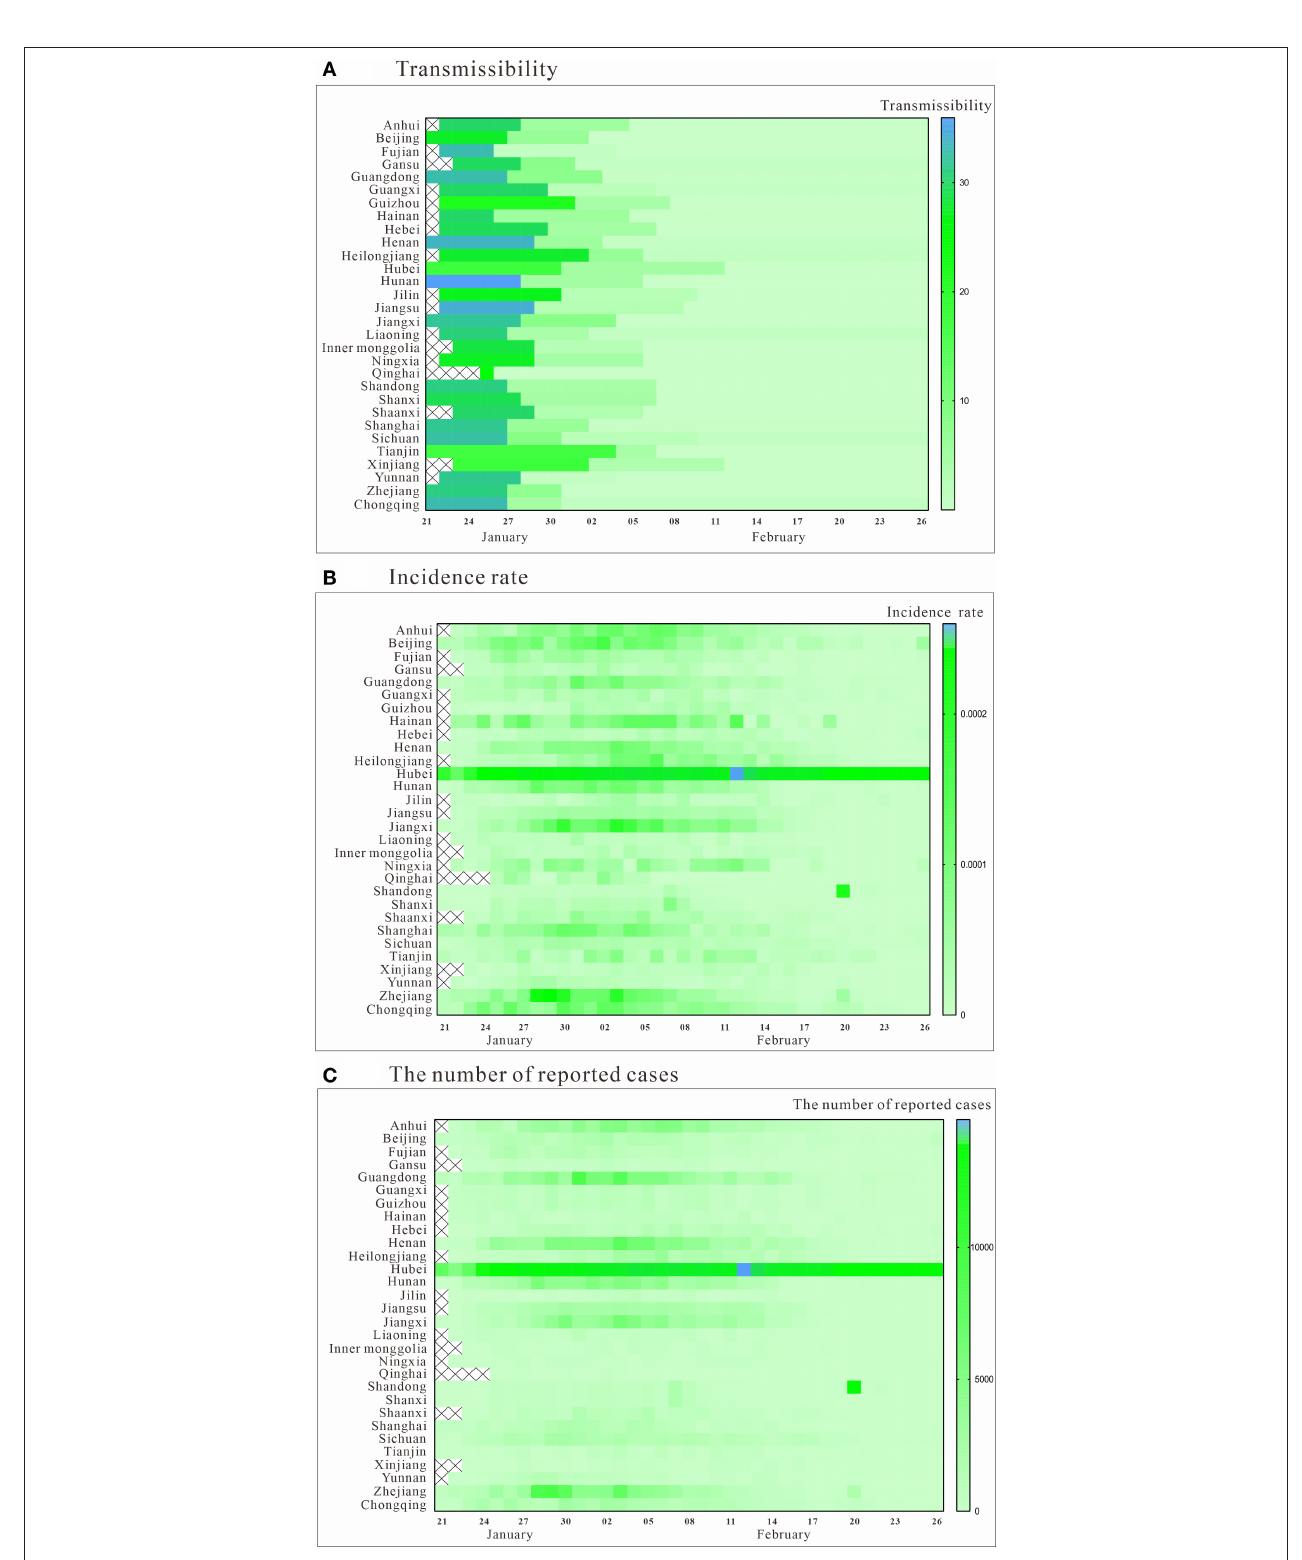
FIGURE 2 | Trend of transmissibility, incidence rate, and the number of reported cases. (A) transmissibility; (B) incidence rate; (C) the number of reported cases.